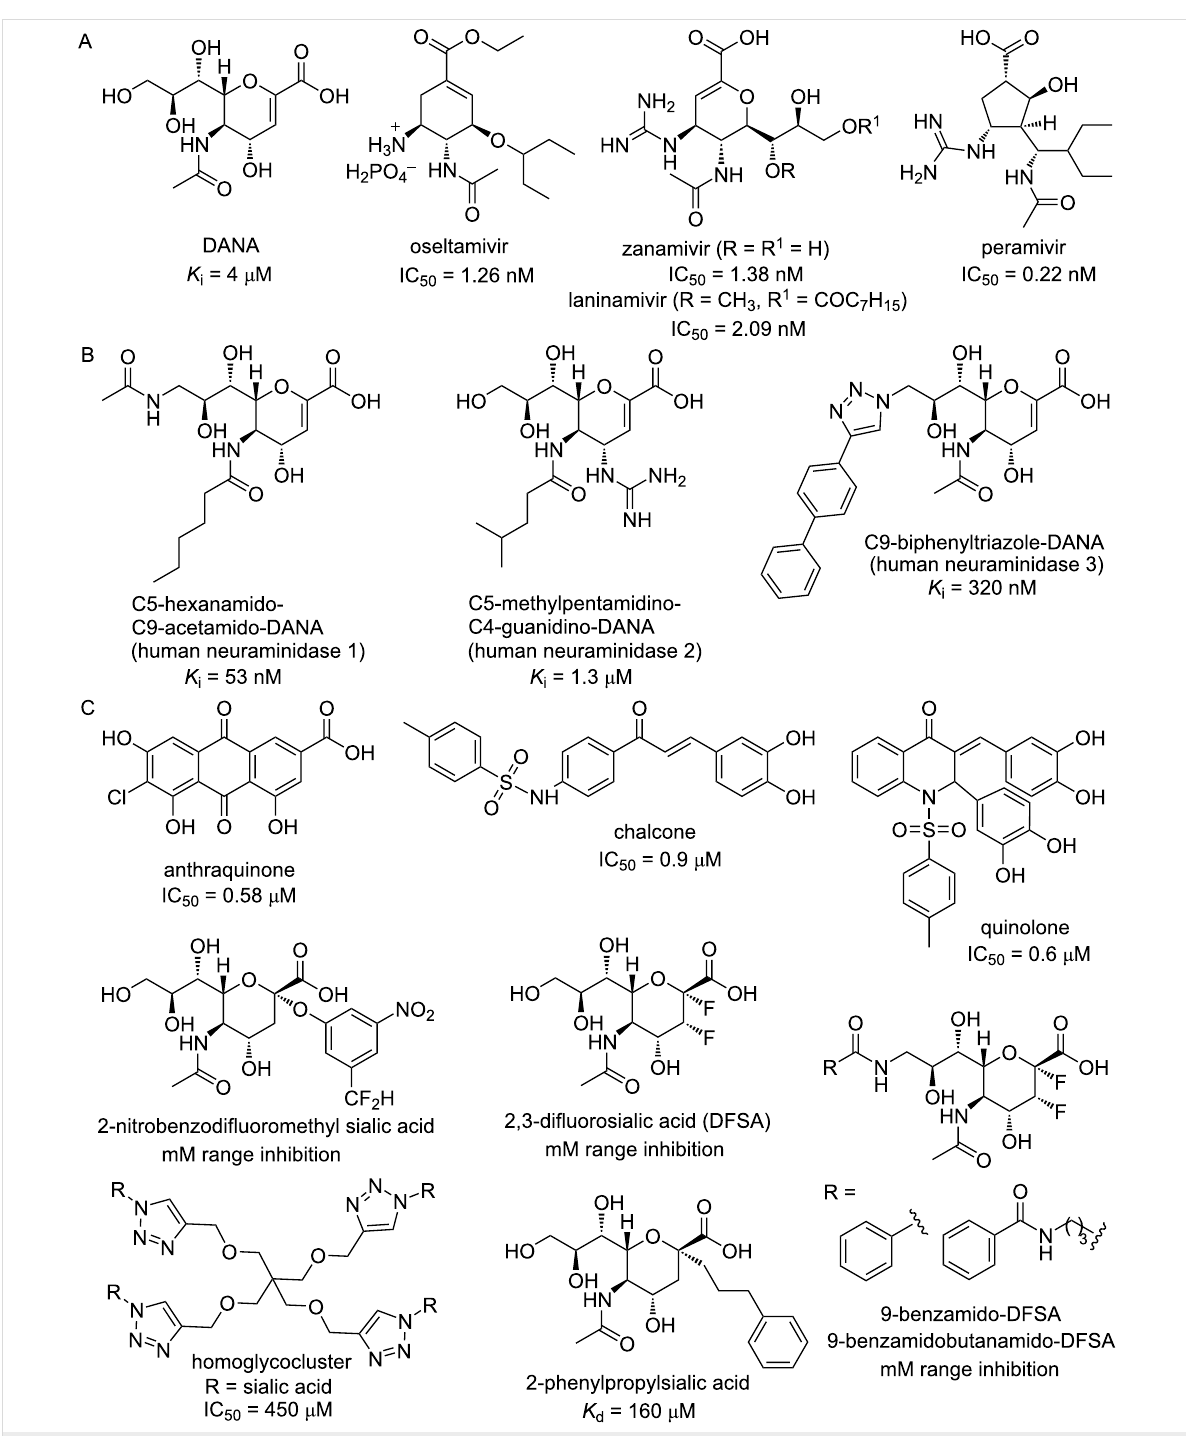
Figure 1: Chemical structures and reported activities of viral (A), human neuraminidases (B) and Trypanosoma cruzi trans -sialidase (TcTS) (C) inhibi-